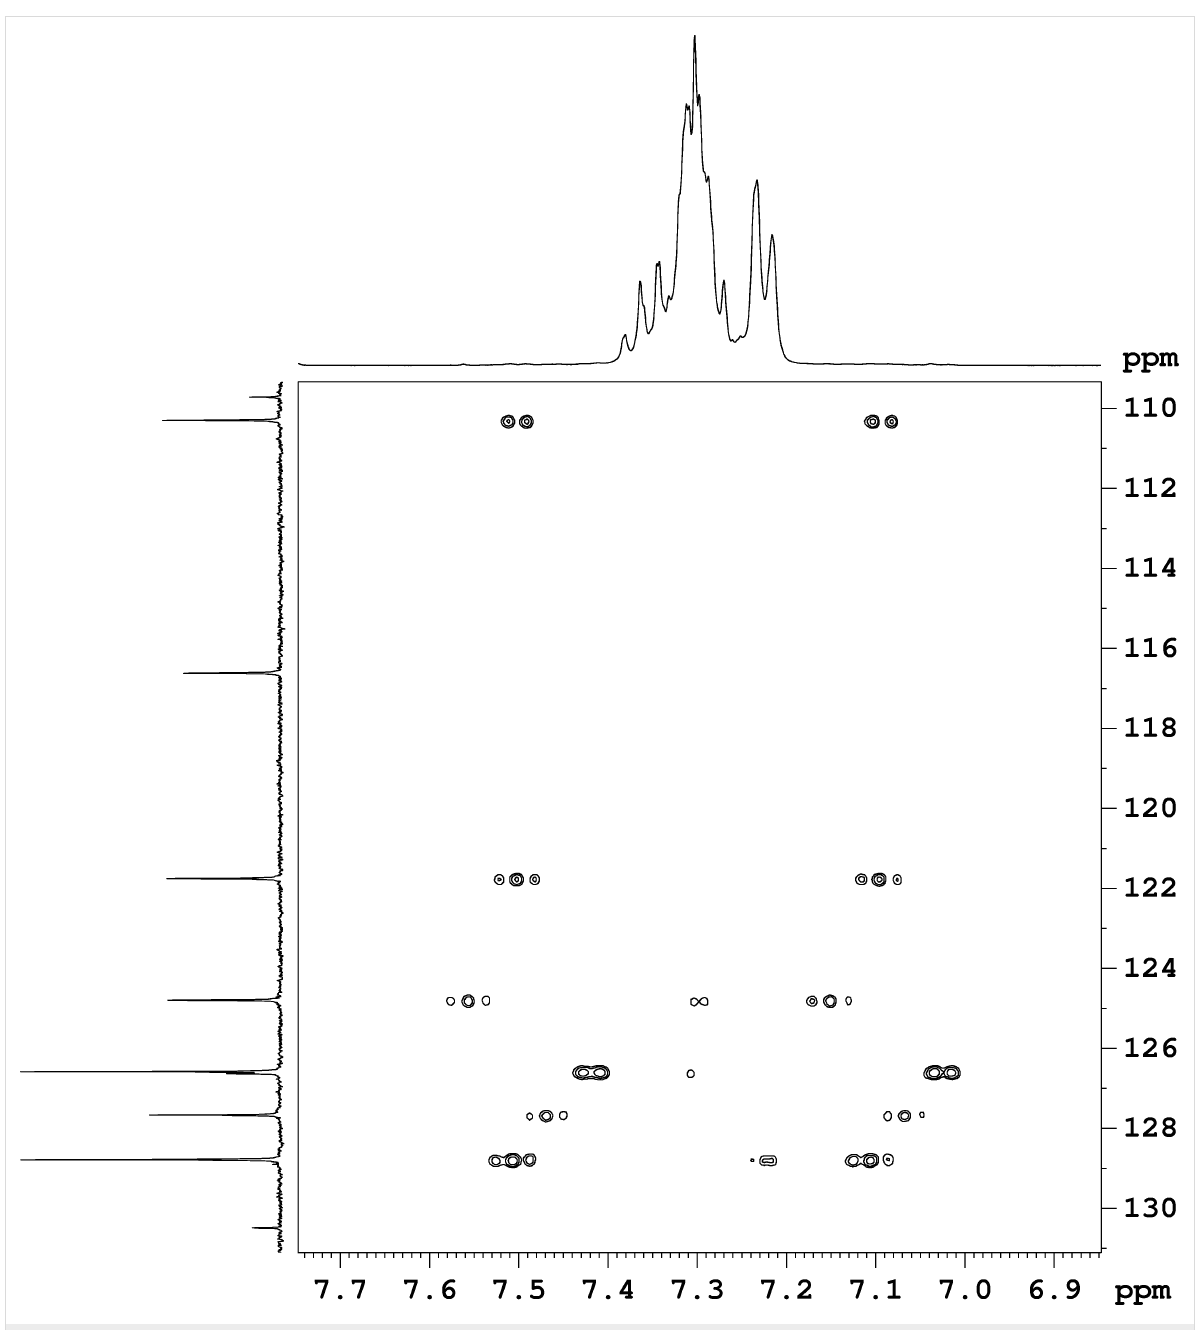
Figure 1: Undecoulpled H,C-HSQC spectrum for compound 5h .